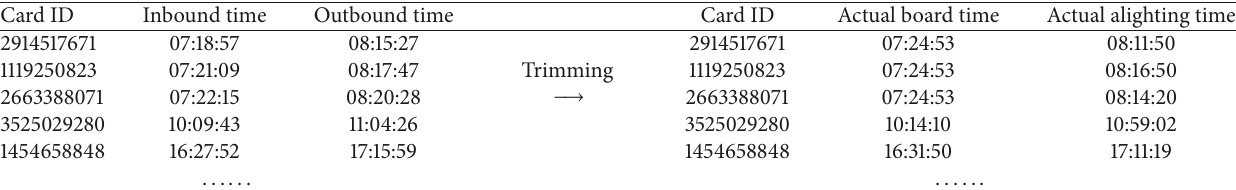
Table 2: Process of AFC data trimming.